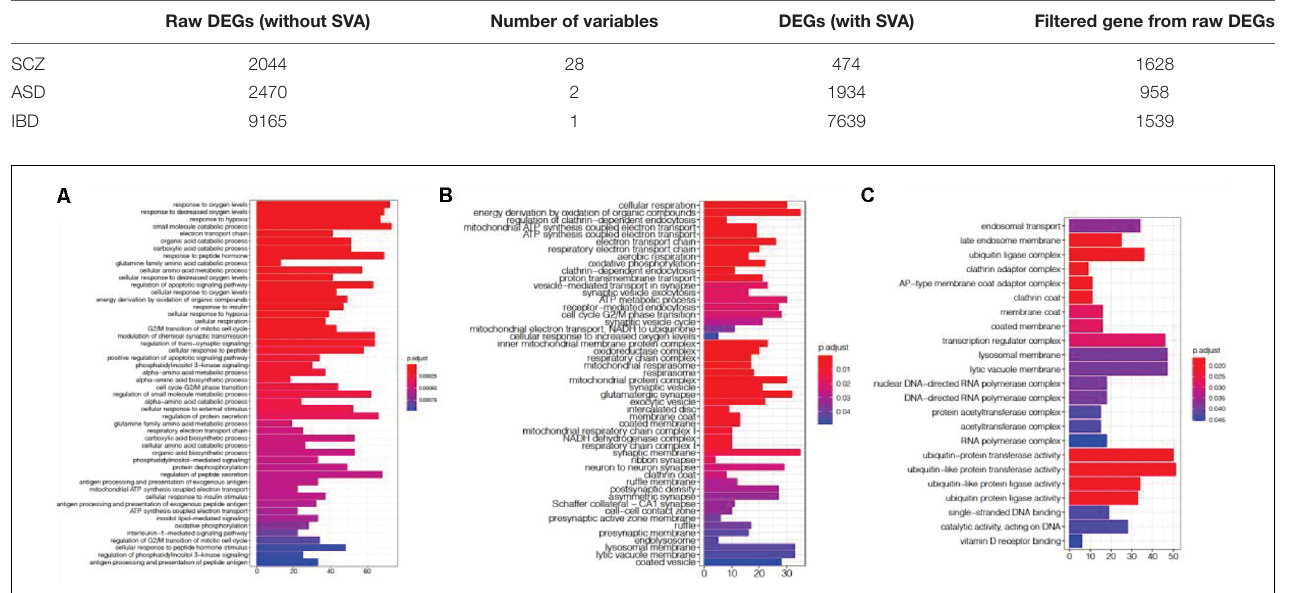
TABLE 2 | Data replication for SVA correction.